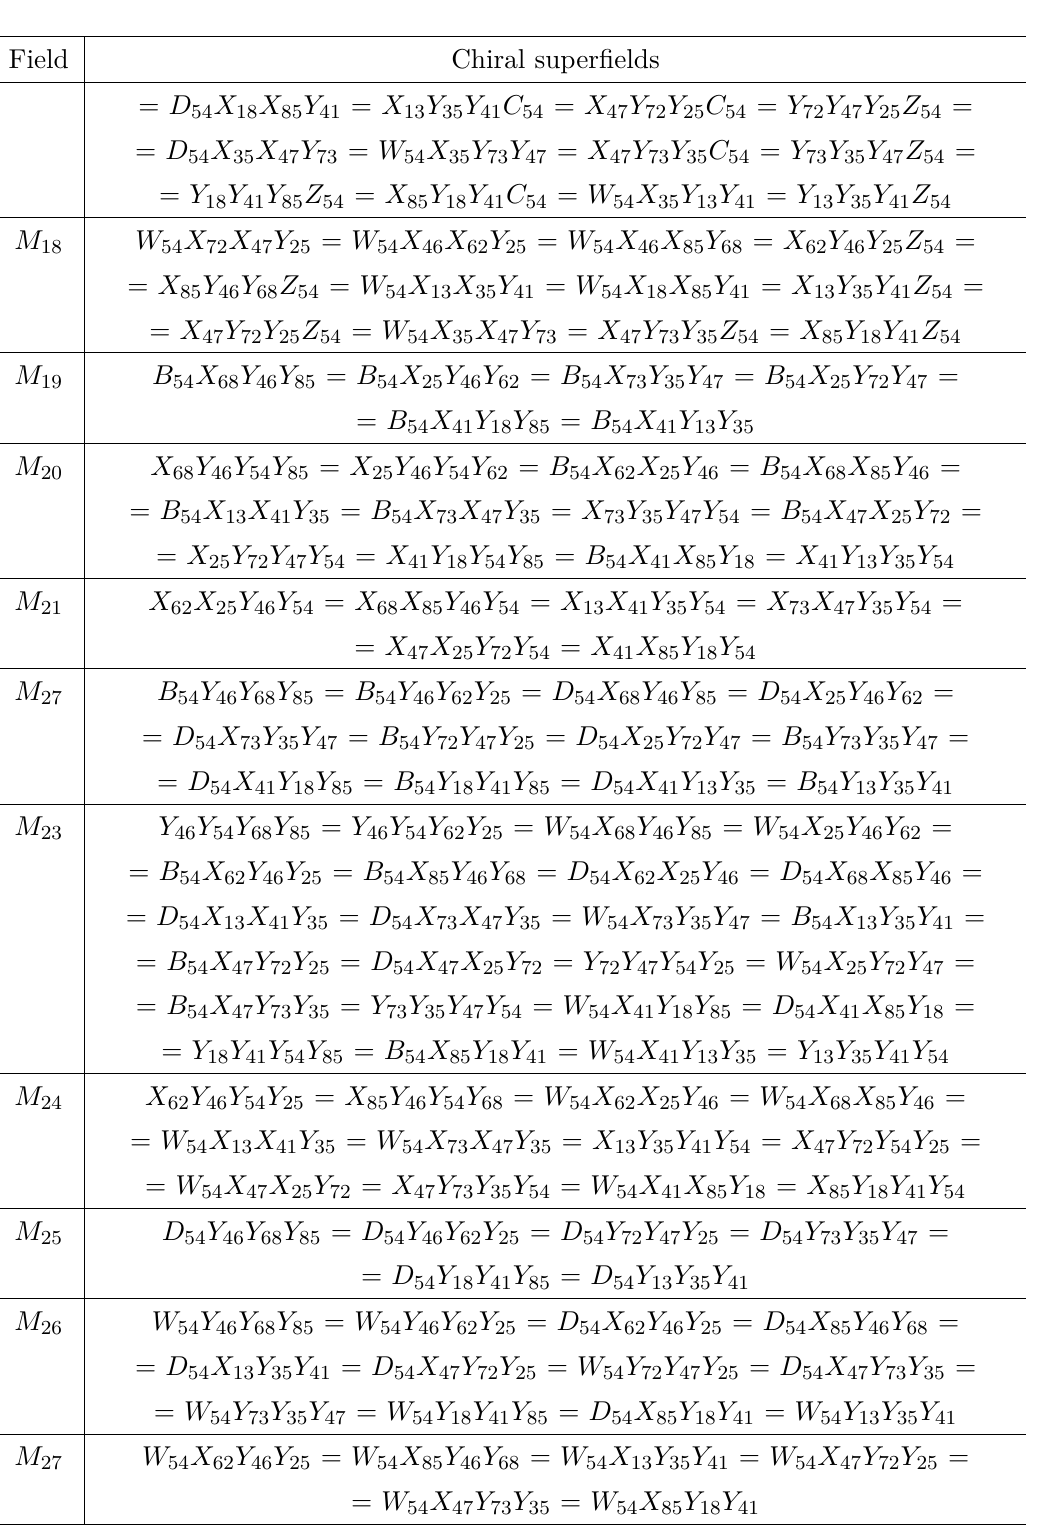
Table 11. Generators of Q 1 , 1 , 1 / Z 2 in Phase